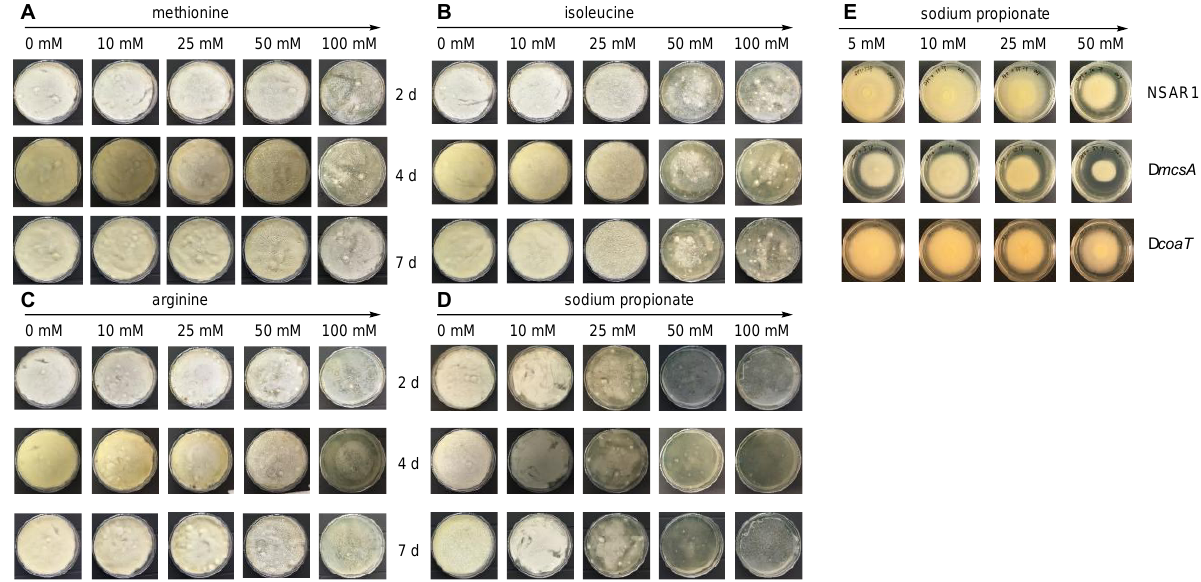
Figure 2. Susceptibility of A. oryzae NSAR1 to different amino acids and propionate at the indicated concentrations and times. ( A ) Methionine; ( B ), isoleucine; ( C ) arginine; ( D ) sodium propionate; ( E ) susceptibility of indicated mutants to indicated concentrations of sodium propionate after 5 days.